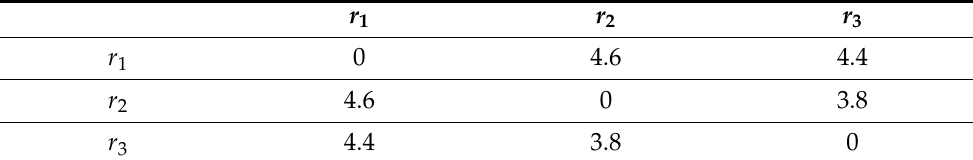
Table 5. Distances between reserves (normalized data) measured with Euclidean distance.